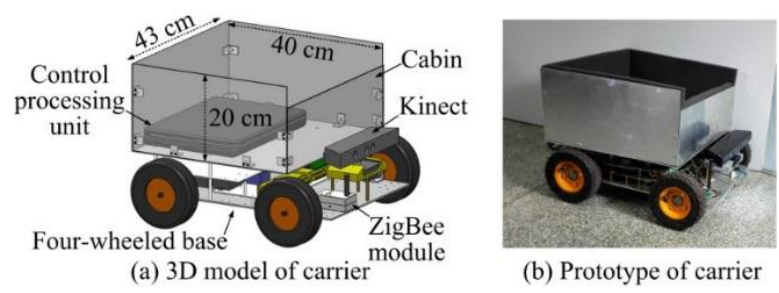
Figure 11. 3D model and prototype of the carrier.